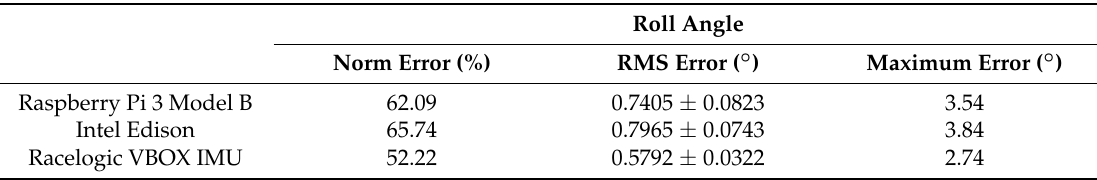
Table 3. Test 1. Errors of estimated roll angle on Raspberry Pi 3 Model B and Intel Edison compared with the measured roll from VBOX (ground truth).